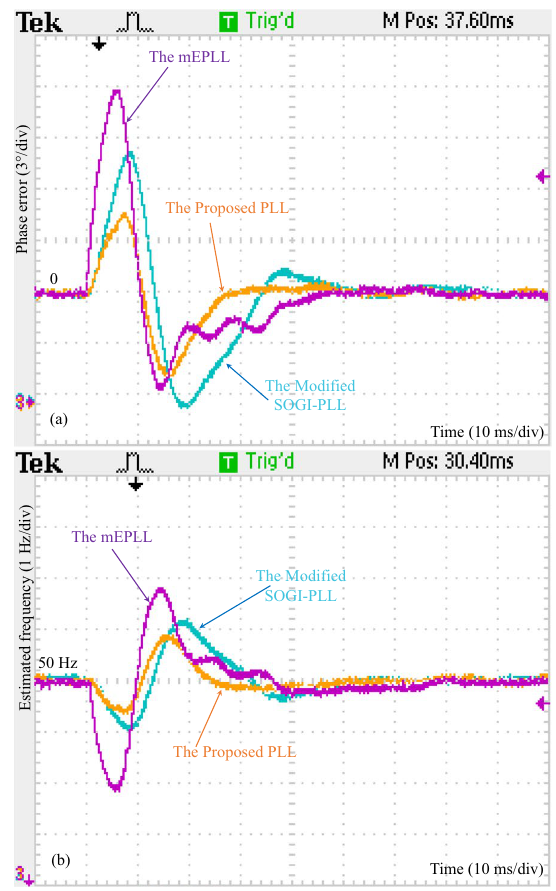
Fig. 17 Experimental results under a 0.15 pu DC offset. CH1, CH2, and CH3 show the responses of the proposed PLL, mEPLL, and modified SOGI-PLL, respectively. a Estimated phase error and b estimated grid